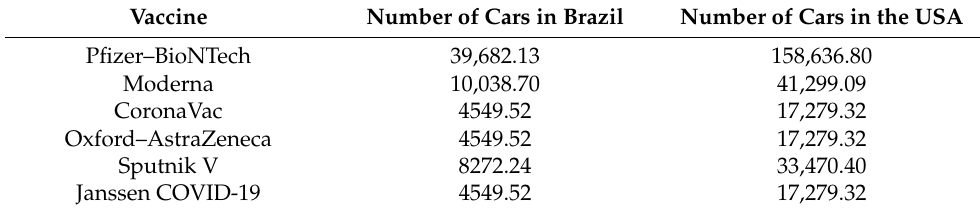
Table 8. CO 2 generated by number of cars in Brazil and the